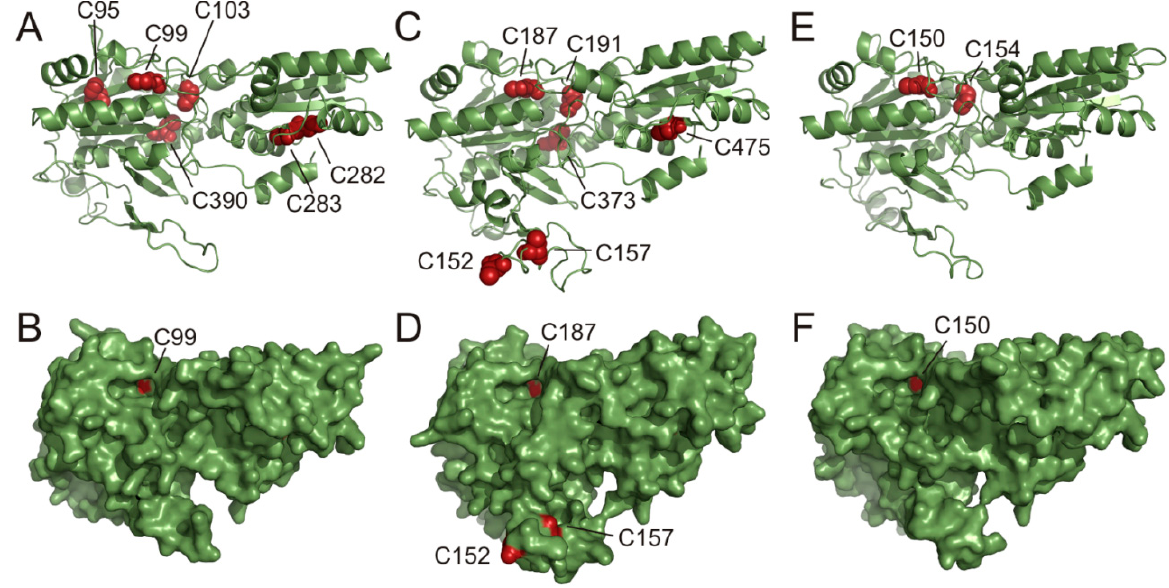
Figure 3. Predicted AtPFK3, AtPFK4 and AtPFK5 3D structures. Based on the 42% identity to the amino acid sequence of the PFK apoenzyme from Trypanosoma brucei , the AtPFK3 ( A , B ), AtPFK5 ( C , D ) and PFK4 ( E , F ) structures were predicted using Phyre2 software. ( A , C , E ) Ribbon representation of the protein architecture, with conserved Cys and their position in red. ( B , D , F ) Solvent-excluded surface with the Cys C152 and C157 in red, representing the AtPFK5 CXDXXC motif.